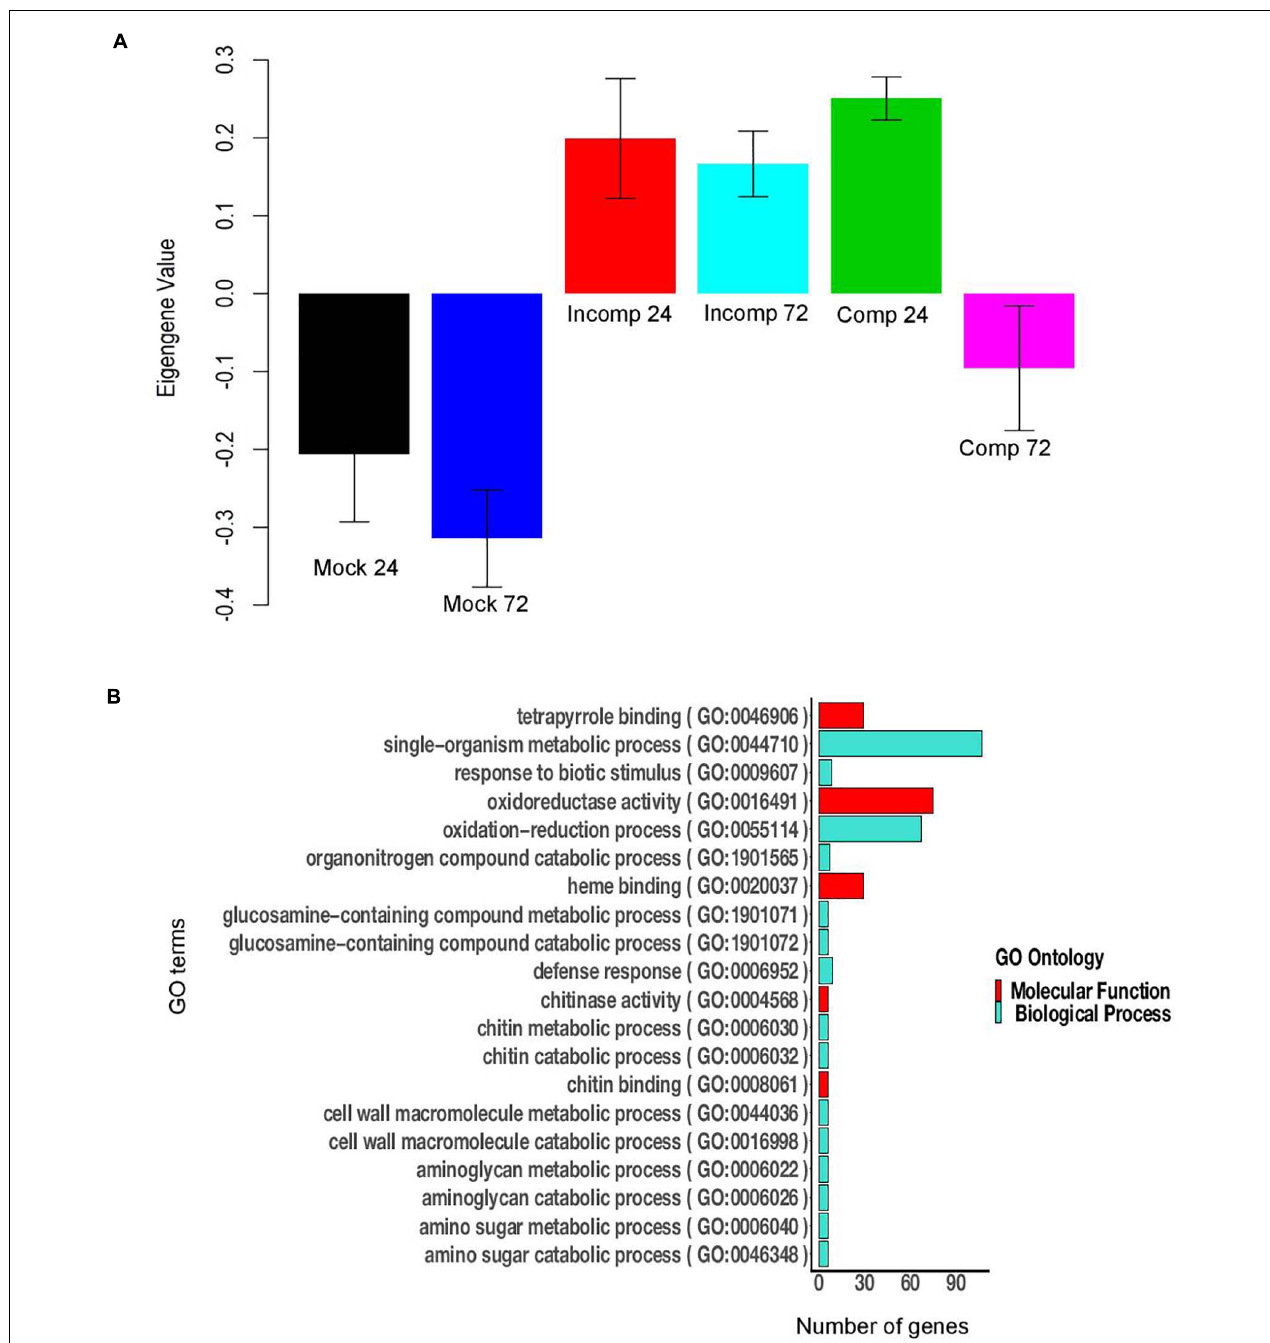
FIGURE 5 | Module 11 of sorghum contains 676 genes. (A) Bar plot of module eigengene expression values for different groups. “Mock 24” indicates mock at 24 h after inoculation (hai), “Mock 72” indicates mock at 72 hai, “Incomp 24” indicates incompatible interaction at 24 hai, “Incomp 72” indicates incompatible interaction at 72 hai, “Comp 24” indicates compatible interaction at 24 hai, and “Comp 72” indicates compatible interaction at 72 hai. Error bars indicate standard deviations of the mean of three biological replicates. (B) The 20 significant GO terms (FDR < 0.05) enriched in module 11 of